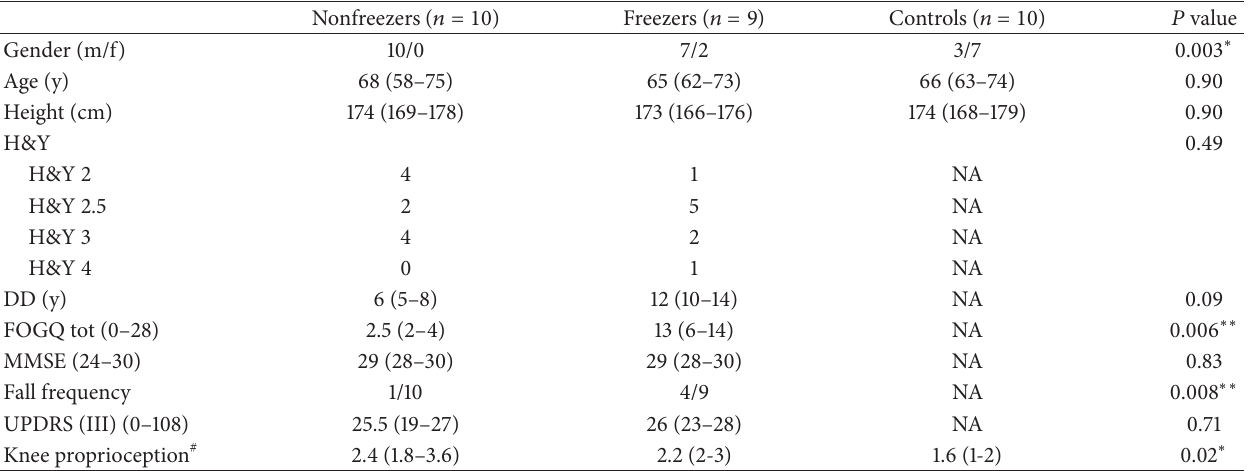
Table 1: Clinical variables of nonfreezers, freezers, and